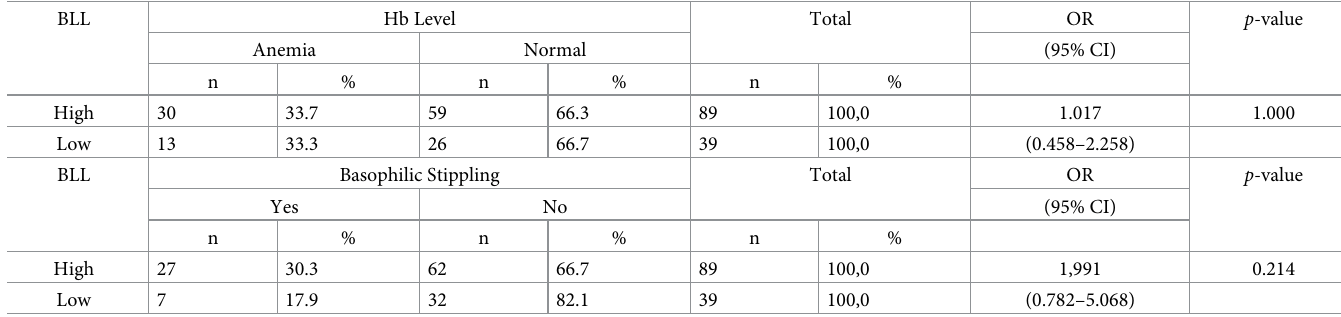
Table 3. Relationship of BLL with hematological